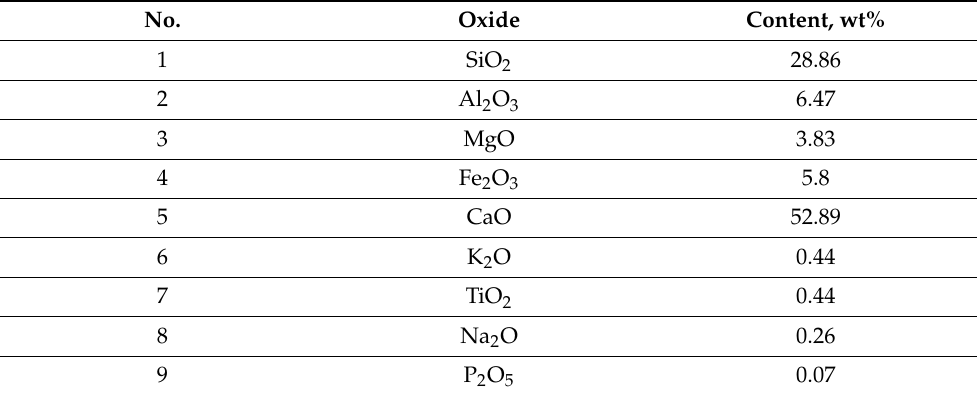
Table 5. The chemical composition of the condensed